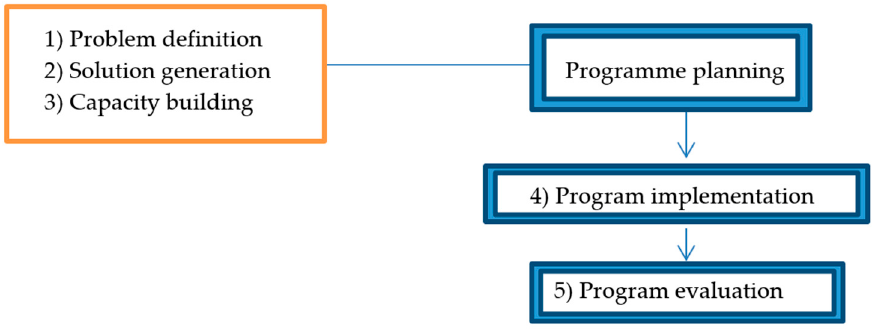
Figure 2. Three planning steps within Nutbeam’s model for health promotion.